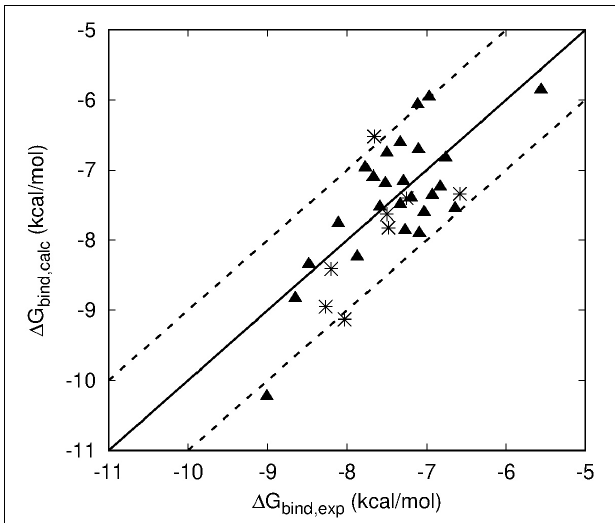
FIGURE 4 | Scattered plot of LIE calculated ( Y axis) and experimental ( X -axis) binding affinities of all HFI compounds that have experimentally determined K i values for WT (triangles) and F544I/V mutant version (stars) of IRAP. Main line denotes perfect agreement with experiments, while the two dashed lines are +/– 1 kcal · mol - 1 .